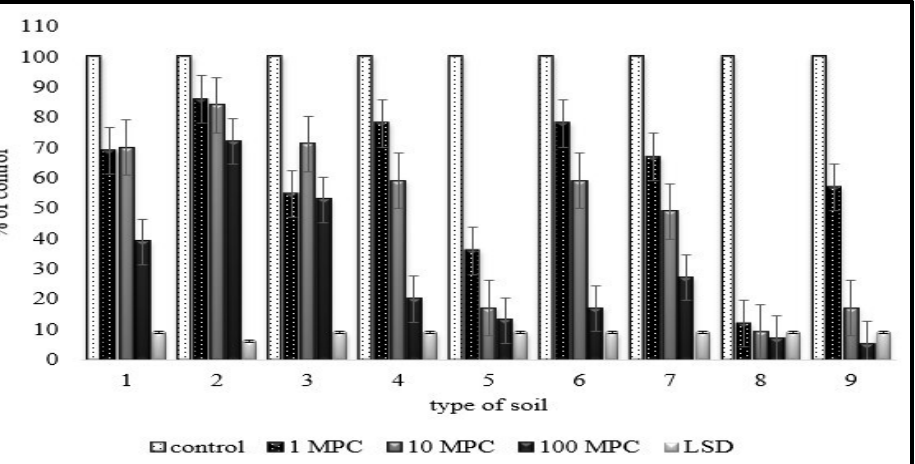
Figure 5. Changes in the length of the radish ( Raphanus sativus ) roots in forest soils: 1, brown leached soil; 2, brown typical soil; 3, brown carbonate soil; 4, yellow soil; 5, acid brown forest soil; 6, sod- carbonate typical soil; 7, leached sod-carbonate soil; 8, acid brown forest podzolized soil; 9, brown forest slightly unsaturated soils.